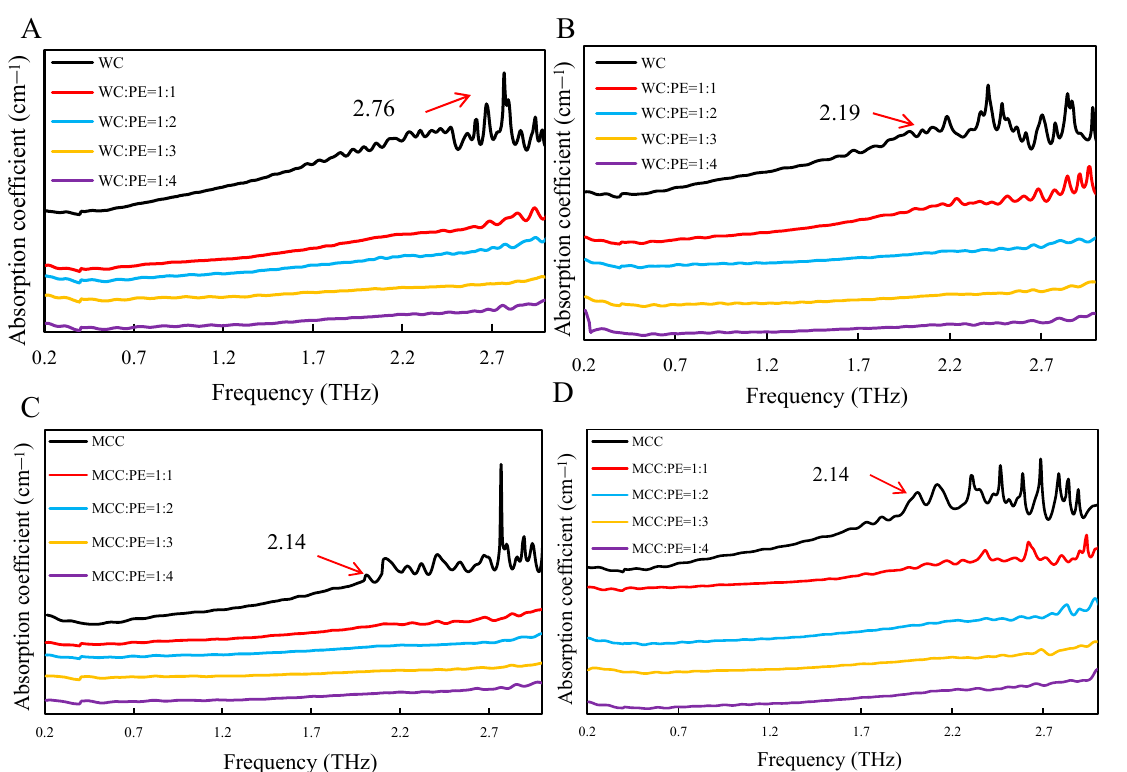
Figure 6. THz test of samples with different mass ratio. ( A ) WC with 0.8 mm thickness, ( B ) WC with 1 mm thickness, ( C ) MCC with 0.8 mm thickness, and ( D ) MCC with 1 mm thickness.